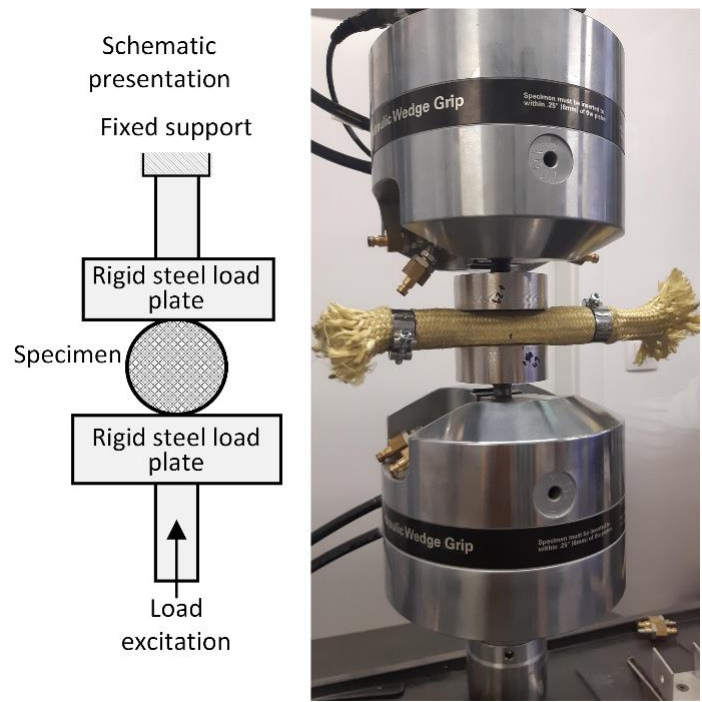
Figure 9. Application of compressive load to the sleeve in radial direction.